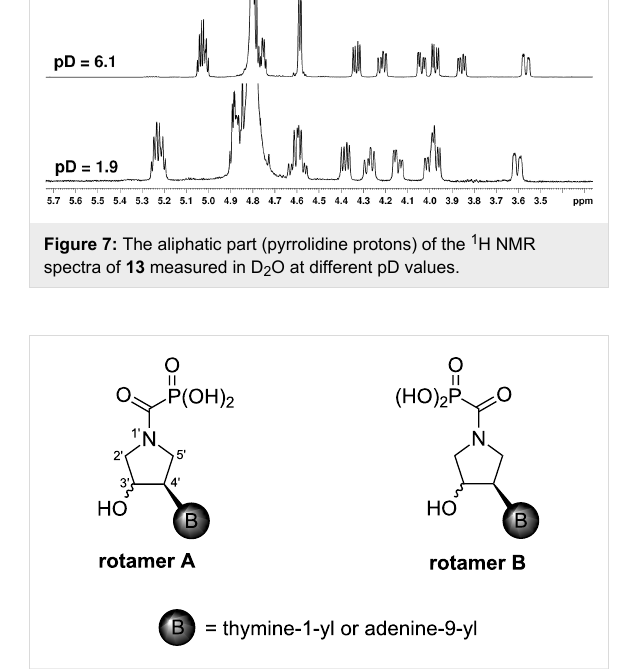
80.7 kJ/mol; the enthalpy of activation Δ H ‡ = 23.8 kJ/mol;